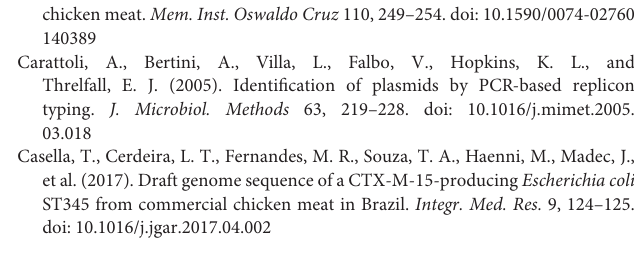
Supplementary Figure 1 | Chromosomal localization of the bla CTX − M − 2 gene by I-Ceu-I-PFGE and Southern blot hybridization. Columns 1 (Isolate 19) and 2 (Isolate 30) depict the hybridization results using an intragenic bla CTX − M − 2 gene probe, whereas columns 3 ( S. enterica ser. Braenderup strain H9812—marker), 4 (Isolate 19), and 5 (Isolate 30) depict the hybridization results using intragenic 16S rDNA